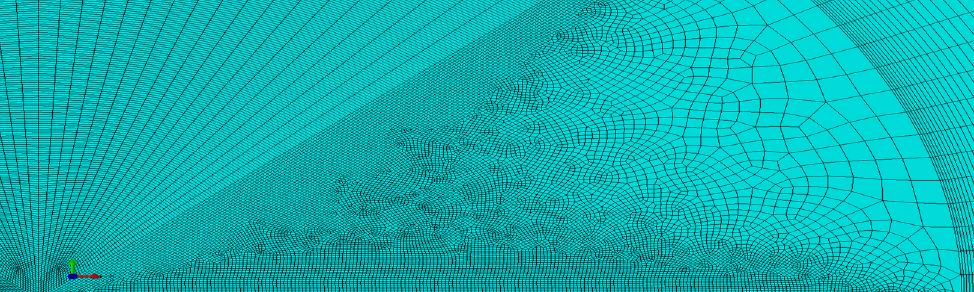
Figure 4. Finite element mesh in the crack tip neighborhood. Figure 4 . Finite element mesh in the crack tip neighborhood.